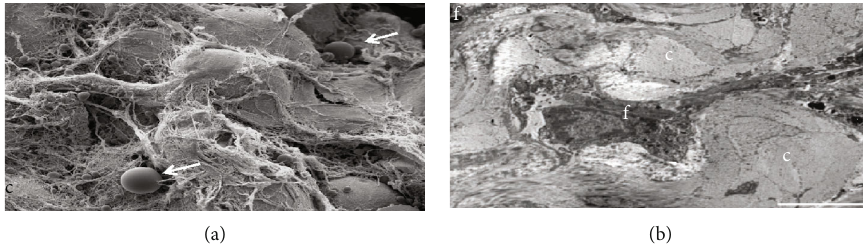
Figure 5: Scanning electron microscopy of the skin. Structural analysis of the deep layer of the dermis: (a) SEM shows an intense collagen network and in fl ammatory cells in reticular dermis (white arrows); (b) MET shows the presence of numerous fi broblasts in reticular dermis and collagen fi bers in formation. f: fi broblast ; c: collagen